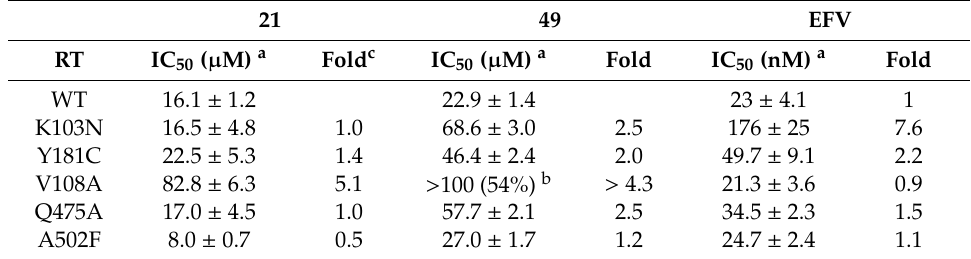
Table 3. Inhibition of HIV-1 RDDP activity of mutated HIV-1